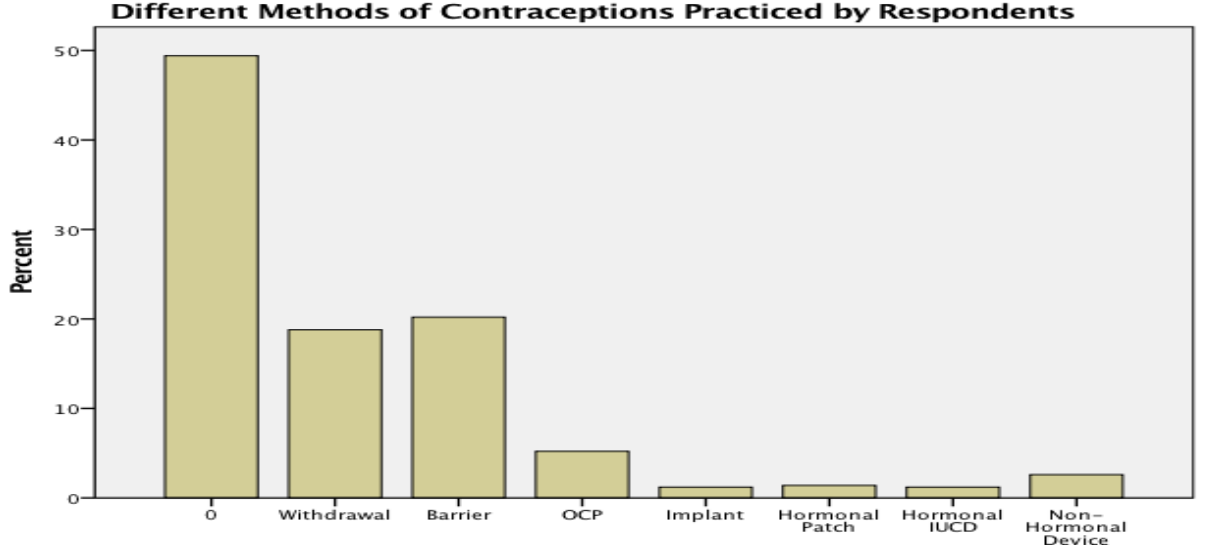
Figure 2. Different methods of contraception used by respondents (Abbreviation OCP stands for oral contraceptive pills; IUCD stands for intra-uterine contraceptive device; 0 stands for non-contraceptive users). Oral contraceptive pills (OCP) were used by only 5%, while other methods were negli- gibly used. The majority of respondents (49%) did not practice any sort of contraception (Bar with 0). Figure 3 highlights different reasons for not practicing contraception. The main reason (37%) found is the desire to have a male